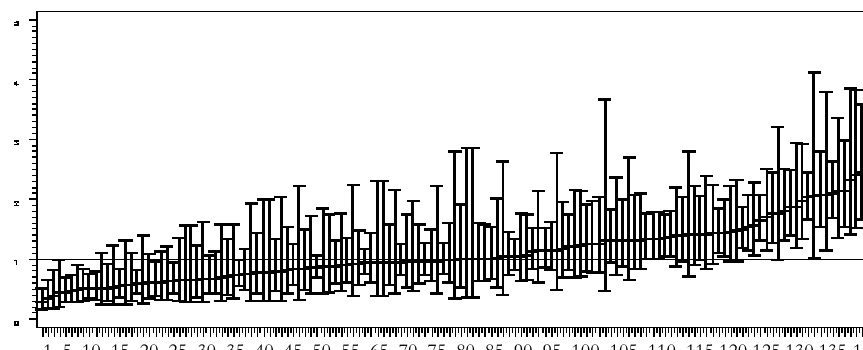
Figura 1 – y 1 mortalità intraospedaliera (intervalli di confidenza per ospedali).